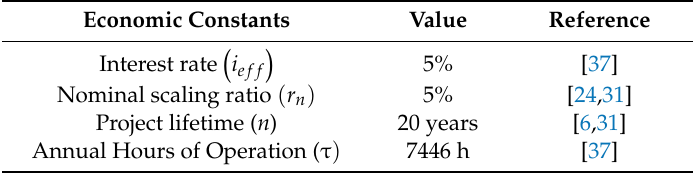
Table 3. Parameters considered in the thermoeconomic